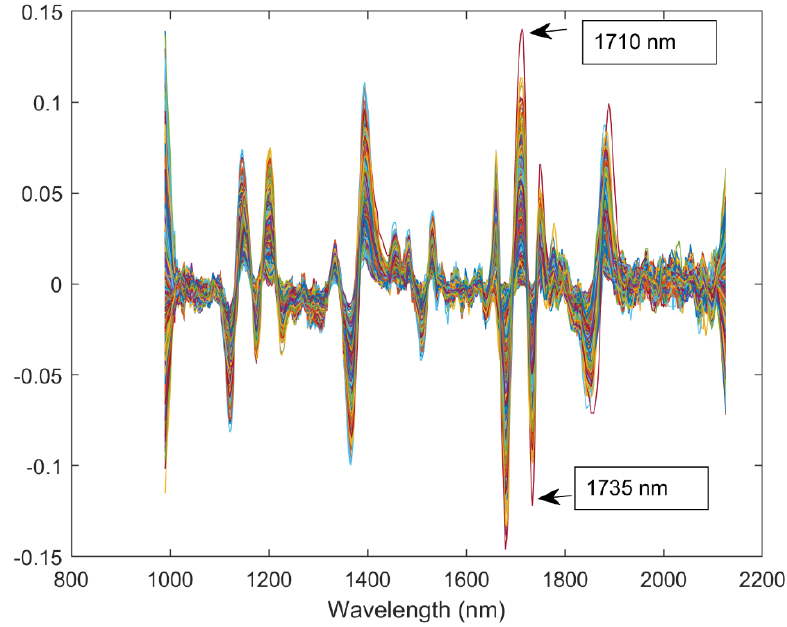
Figure 5. Smoothed second derivative spectra in seasons 2016 and 2017, highlighting the wave- lengths used for the